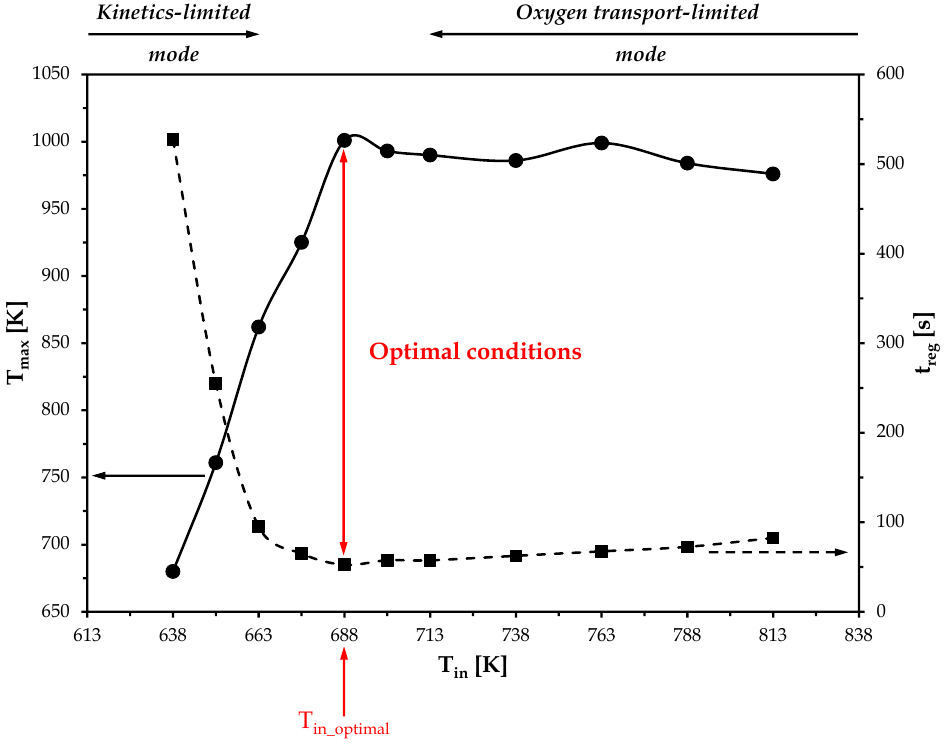
Figure 12. Criterion for the identification of T in_optimal applied to the case of k = 100: T in_optimal lies on the boundary between the oxygen transport-limited mode and the kinetics-limited mode.